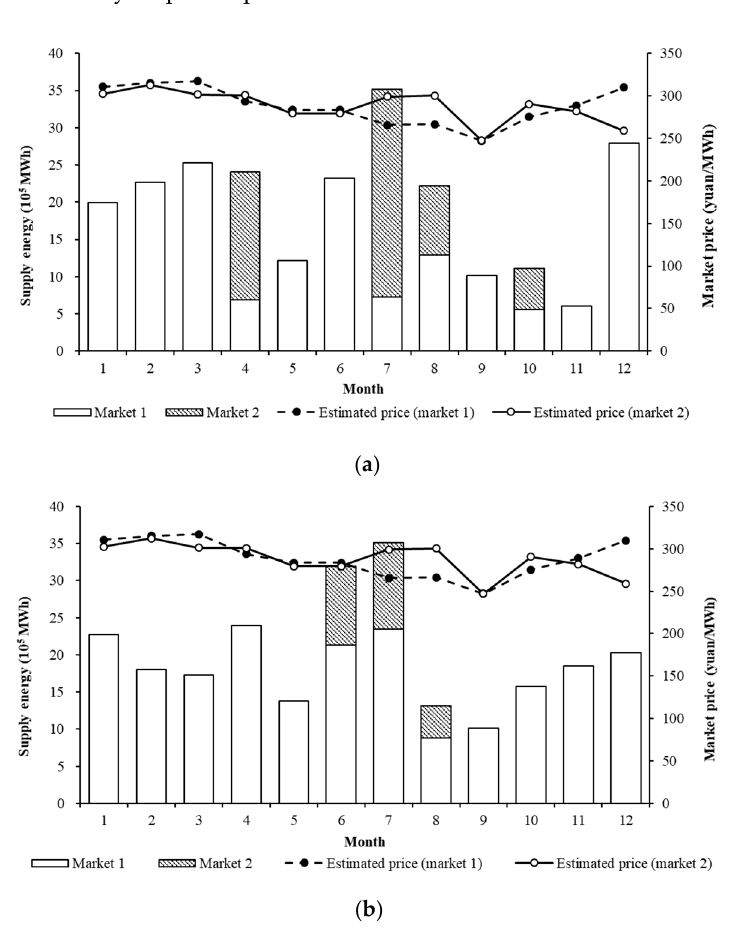
Figure 7. Comparisons of supply energy for two markets. ( a ) The supply energy for two markets obtained by the proposed model; ( b ) The supply energy for two markets obtained by the conventional model.